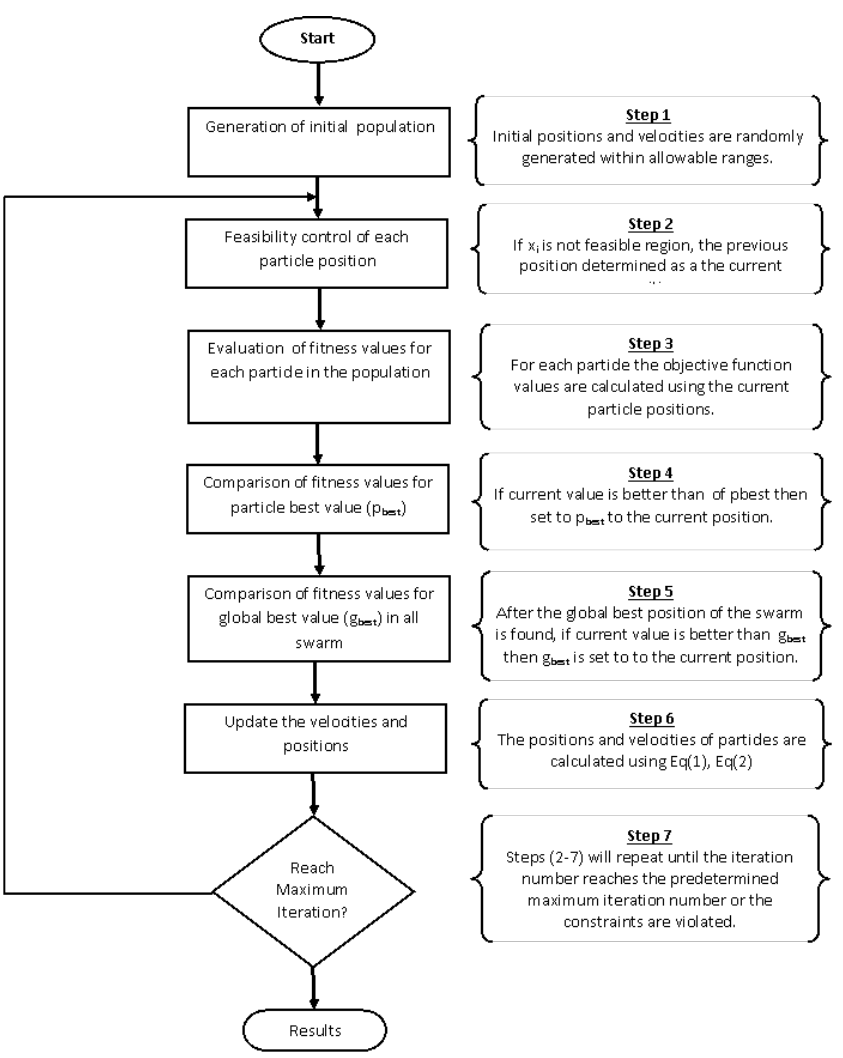
Figure 1. The flowchart of the particle swarm